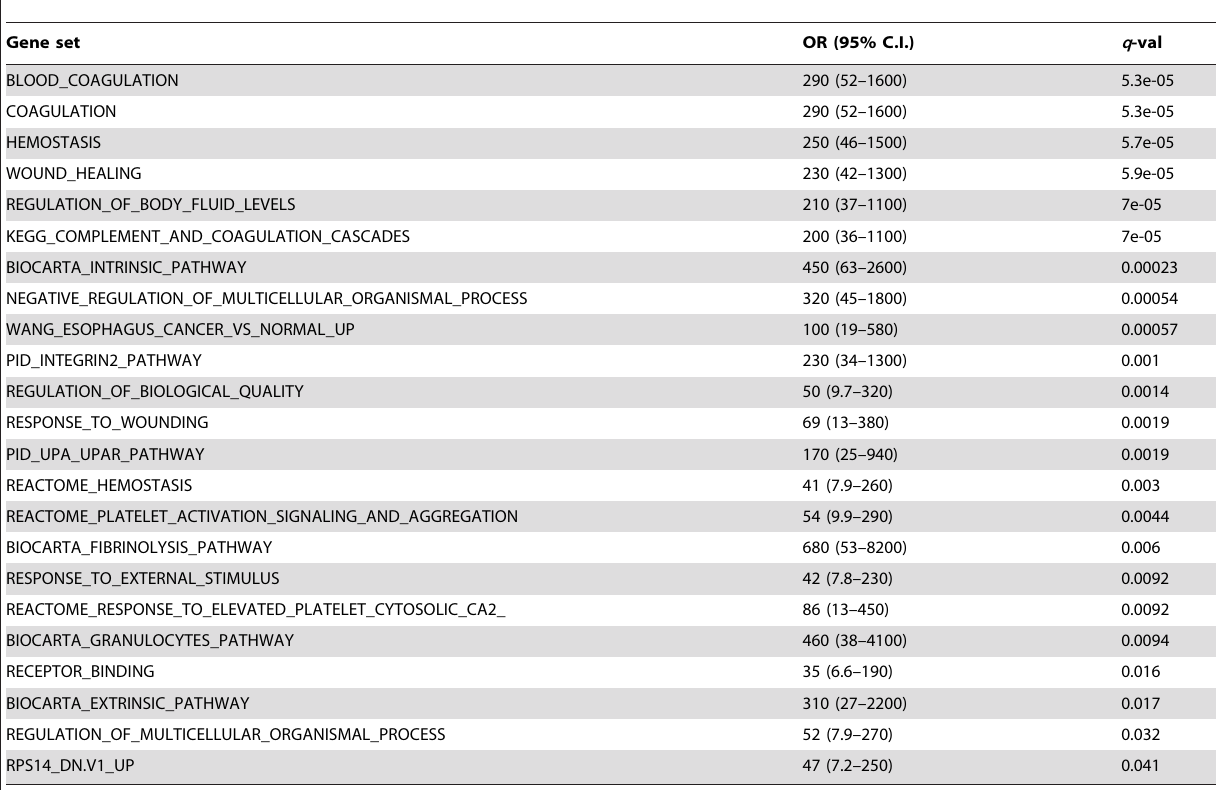
Table 7. Wound-healing module: significantly enriched gene sets.